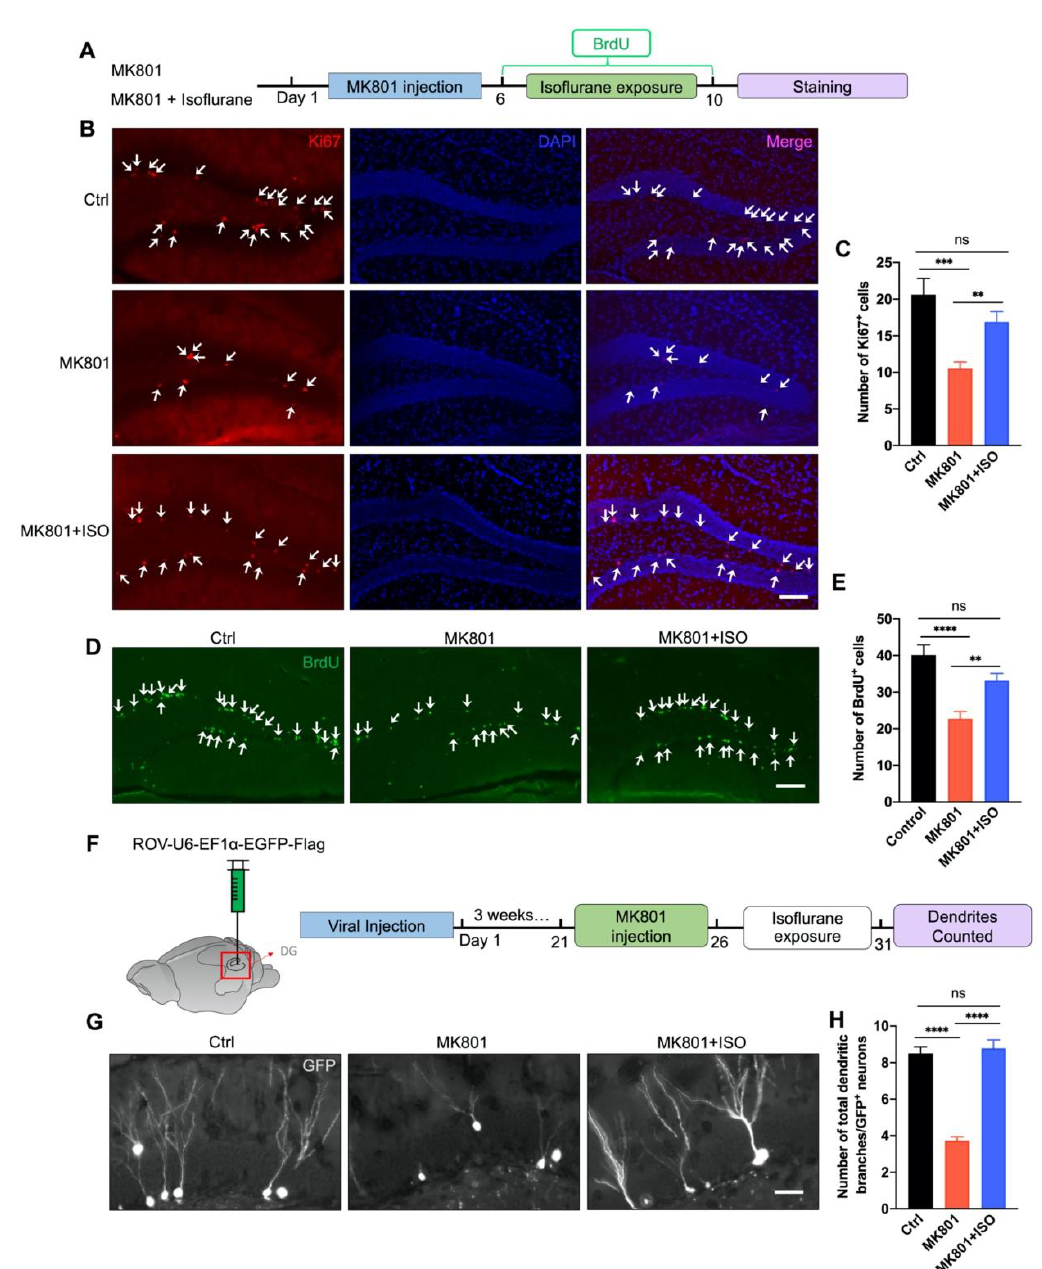
Figure 2. Isoflurane treatment reverses NSCs adult neurogenesis deficit in the DG induced by MK801. ( A ) Schematic of BrdU injection. BrdU was injected twice a day during 5 days of isoflurane exposure. ( B ) Representative photomicrographs showing Ki67-positive cells in the DG, indicated by white arrows. Scale bar, 100 μm. ( C ) Isoflurane inhalation reversed the reduction of Ki67-positive cells in the DG induced by MK801 (five mice in each group and five sections in each animal were picked and counted. One-way ANOVA, F (2, 29) = 9.306, p = 0.0008; post hoc test: Ctrl vs. MK801, p = 0.0005; MK801 vs. MK801+ISO, p = 0.009; Ctrl vs. MK801+ISO, p = 0.08). ( D ) Representative photomicrographs showing BrdU-positive cells in the DG, indicated by white arrows. Scale bar, 100 µ m. ( E ) Isoflurane inhalation reversed the reduction of BrdU+ cells in the DG induced by MK801 (five mice in each group and five sections in each animal were picked and counted. One-way ANOVA, F (2, 28) = 15.33, p < 0.0001; post hoc test: Ctrl vs. MK801, p < 0.0001; MK801 vs. MK801+ISO, p = 0.0012; Ctrl vs. MK801+ISO, p = 0.051). ( F ) Schematic of retrovirus injection. Retrovirus was micro-injected into the DG 21 days before MK801 injection. ( G ) Representative images of the dendrites of